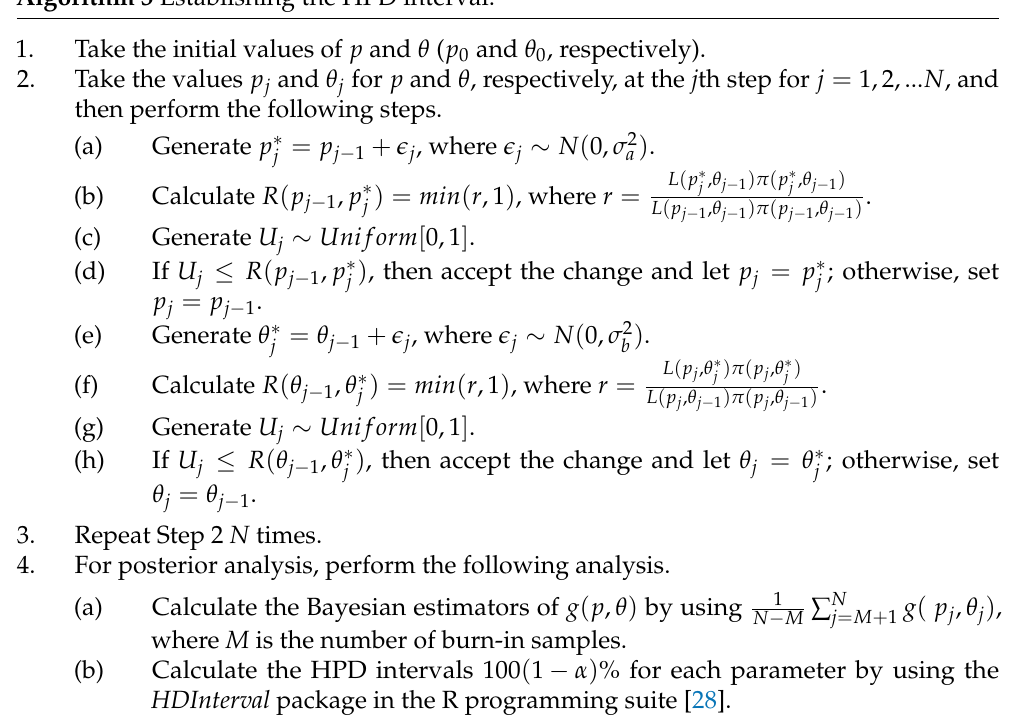
Algorithm 3 Establishing the HPD